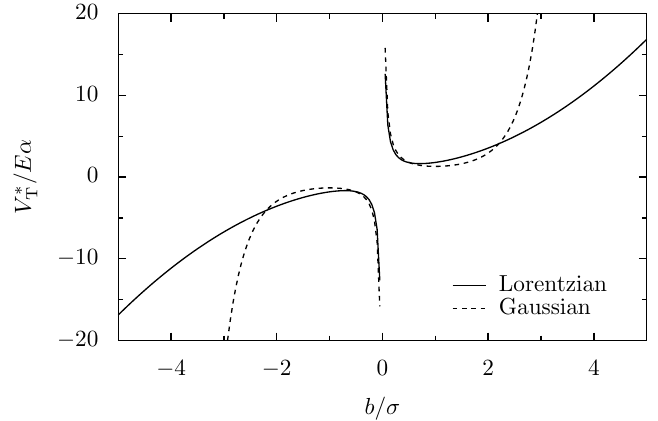
Figure 8: Plot of the tip strength needed to maintain constant deflection as a function of distance from the branch for Lorentzian [ solid lines, Eq. (7) ] and Gaussian [ dashed lines, Eq. (9) ] tip potential